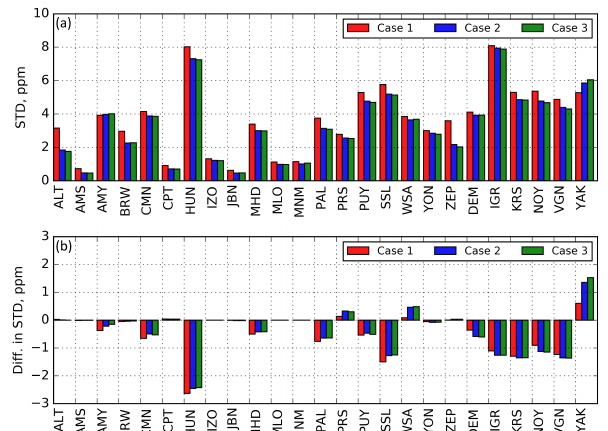
Figure 3. (a) Correlation coefficients between the CO 2 concentra- tions simulated with the coupled model and those observed, (b) dif- ference in correlation coefficients due to the application of the La- grangian component (positive values mean the results of the cou- pled model are better than those of the Eulerian model alone) at the selected WDCGG and JR-STATION locations for 2009–2010. The definitions of the cases 1–3 are in Table 1.